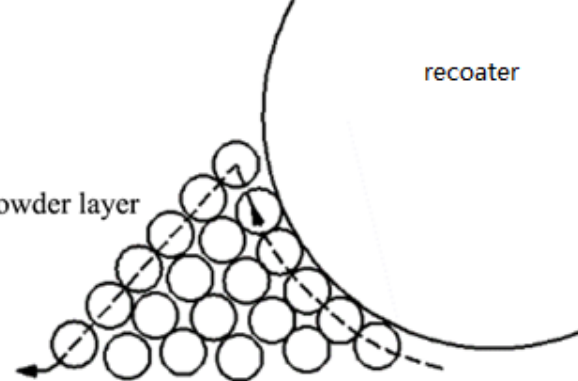
Figure 4. Ideal transport model for powder particles.